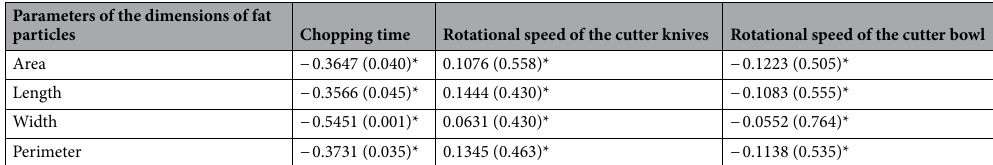
Parameters of the dimensions of fat particles Chopping time